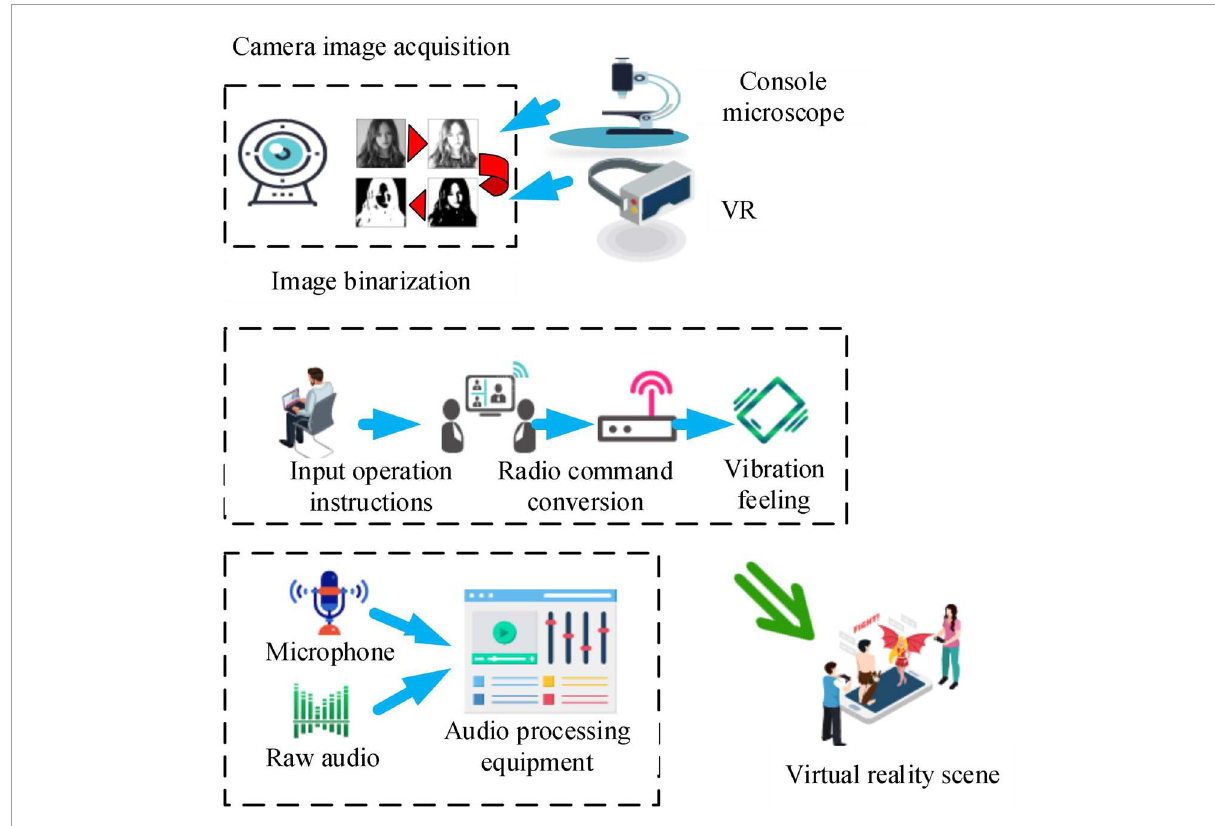
FIGURE2 Structure chart of adolescent psychotherapy